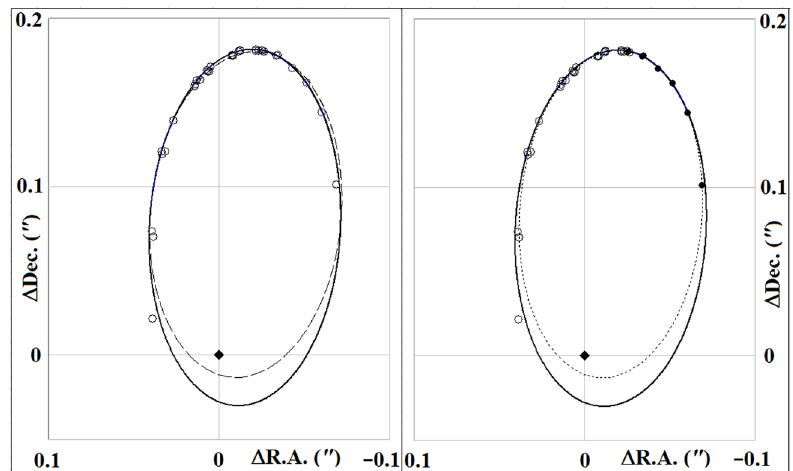
Figure 1: Orbits of S2.